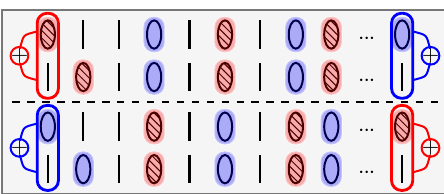
Figure 1. Cartoon of the Haldane phase, showing the presence of two degenerate states with fractional edge modes. The Haldane order consists of the superposition of all possible configurations with a string of alternated holons (empty blue circles) and doublons (patterned red circles) diluted in a background of single electrons with arbitrary spin orientation (black lines). For an open chain, the string starting with the doublon ( top ) and that starting with the holon ( bottom ) are distinct states. Therefore, each edge acquires a fractional charge given by the superposition of either doublons and single occupations or holons and single